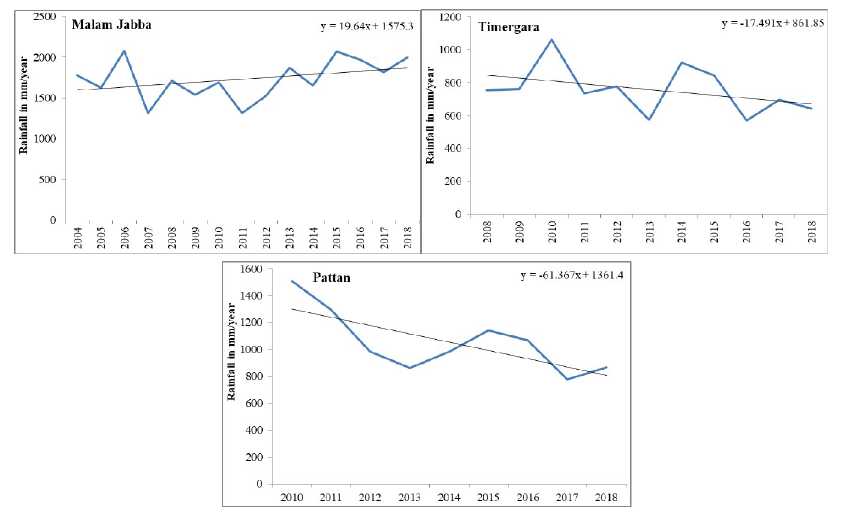
Fig 3. Annual rainfall variation in selected